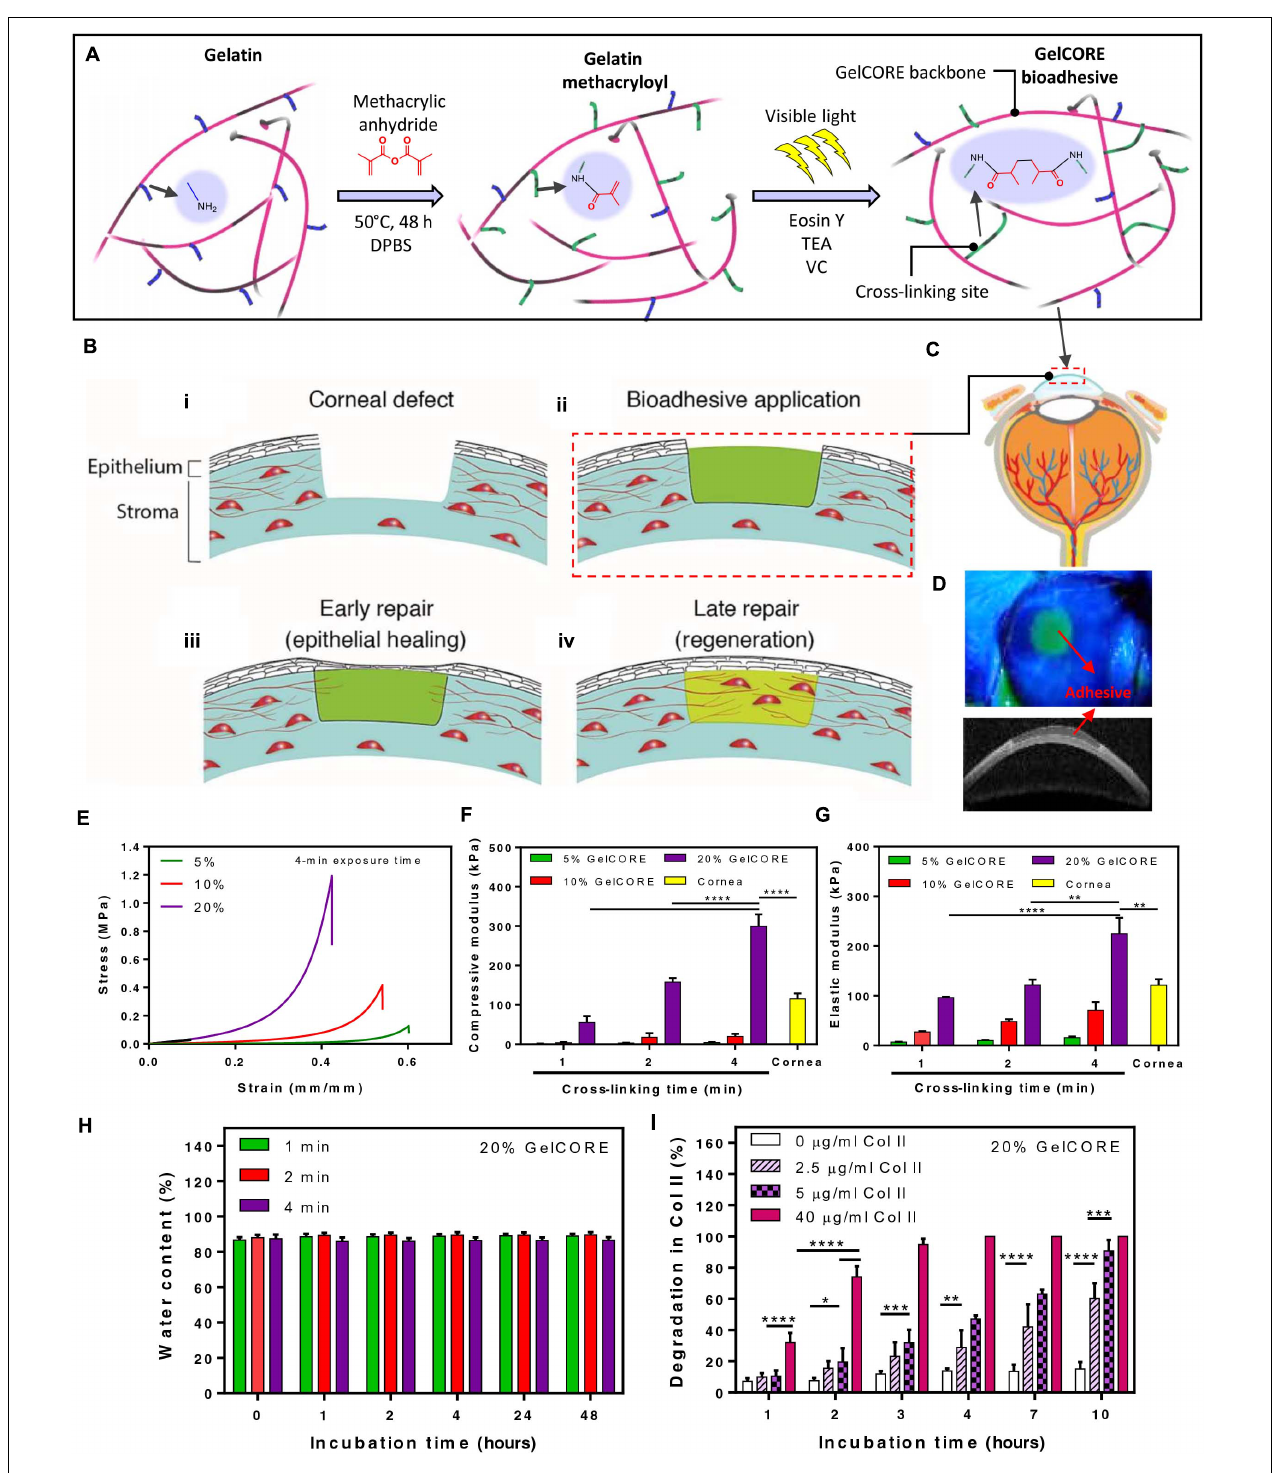
FIGURE 5 | Application of adhesive tissue engineering scaffolds (ATESs) in cornea repair. (A) Mechanism of hydrogel formation. (B) Application of ATES: (i) Corneal defect; (ii) Scaffold application; (iii) Epithelial healing; (iv) Regeneration. (C) Injection of prepolymer into injured cornea. (D) Demonstration of GelCORE hydrogel. (E–G) Compressive stress-strain curve (E) , compressive moduli (F) , and elastic moduli (G) for GelCORE hydrogels at varied concentration and crosslinking time. (H) Water content of GelCORE hydrogel after different crosslinking times at 37 ◦ C. (I) GelCORE degradation in collagenase type II at 37 ◦ C. * P < 0.05, ** P < 0.01, *** P < 0.001, and **** P < 0.0001. Reconstructed with permission from Shirzaei Sani et al. (2019).